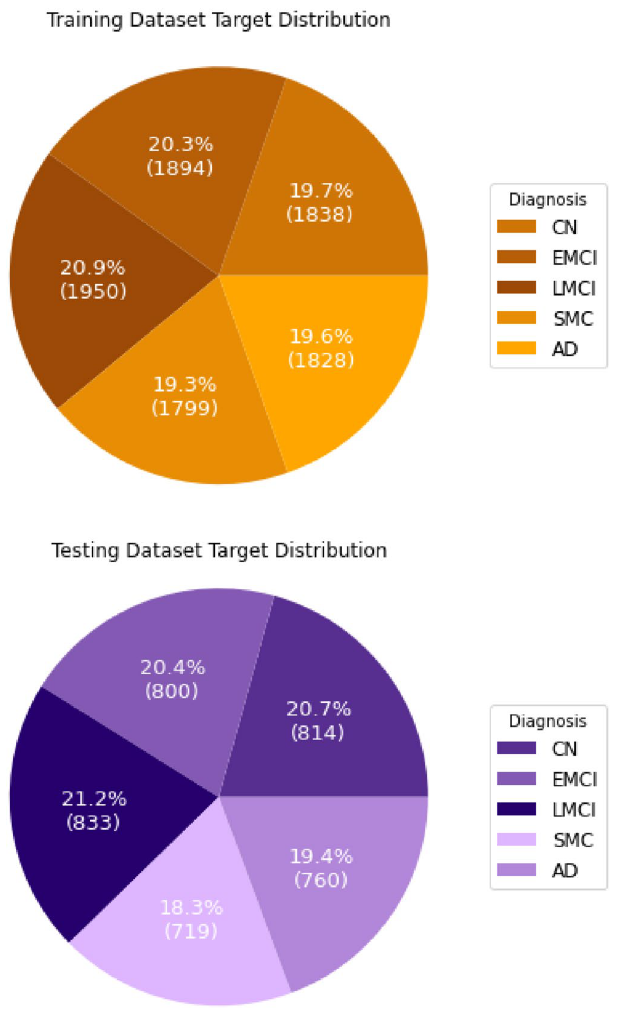
Figure 5. Targets’ distributions after data